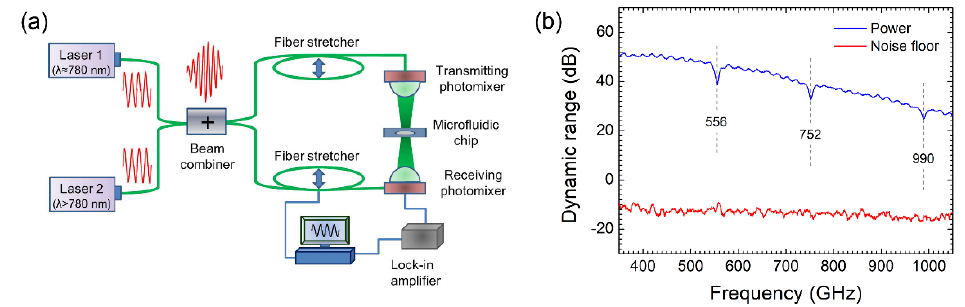
Figure 2. ( a ) Schematic of THz coherent photomixing spectrometer setup and the location of the microfluidic chip adjacent to the photomixers. ( b ) Variations of transmission power, background noise with frequency. Water vapor absorptive attenuations are marked with dashed vertical lines.